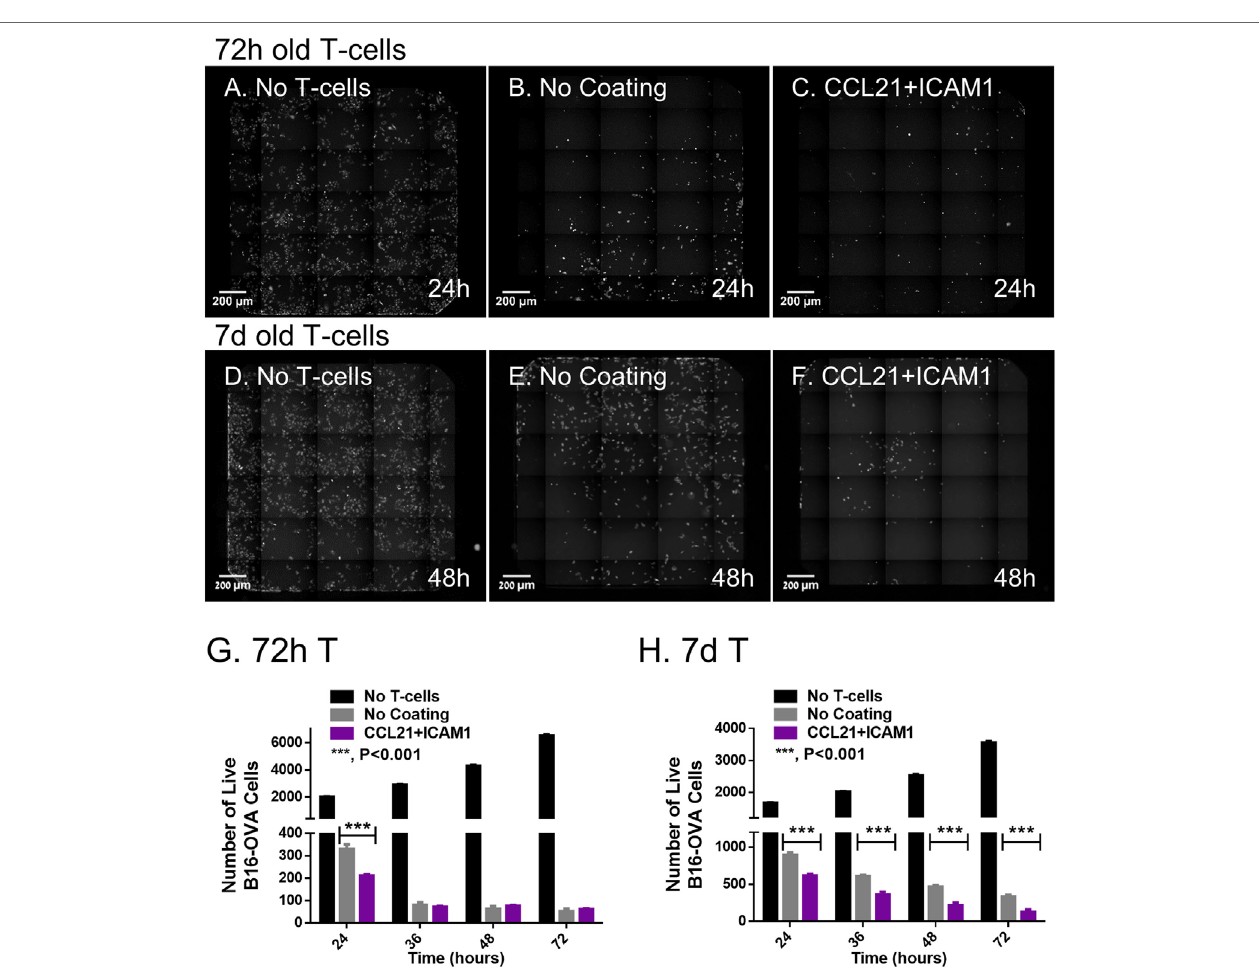
FigUre 4 | Substrate-immobilized CCL21 + intercellular adhesion molecule 1 augment the killing efficiency of cytotoxic T-cells in vitro . CD8 + T-cells, pre-cultured for 72 h (a–c) or 7 days (D–F) , were subsequently co-cultured with B16-ovalbumin-GFP cells, in a 3:1 ratio, respectively. (a–F) Representative fluorescence microscopy images, stitched so that each displays an entire well in a 384-well plate; live B16 cells (expressing GFP) are seen in white. (g,h) Bar graphs illustrating the number of viable B16-ovalbumin cells, in co-cultures with T-cells that were pre-cultured for 72 h (g) or 7 days (h) , as quantified using automated image analysis [data are from one experiment representative of at least three independent experiments with 10 replicates each (see Figure S3A in Supplementary Material). Error bars represent SEM. Calculated p -values (using standard t -test) are as indicated in the Figure]. Scale bar: 200 µm.